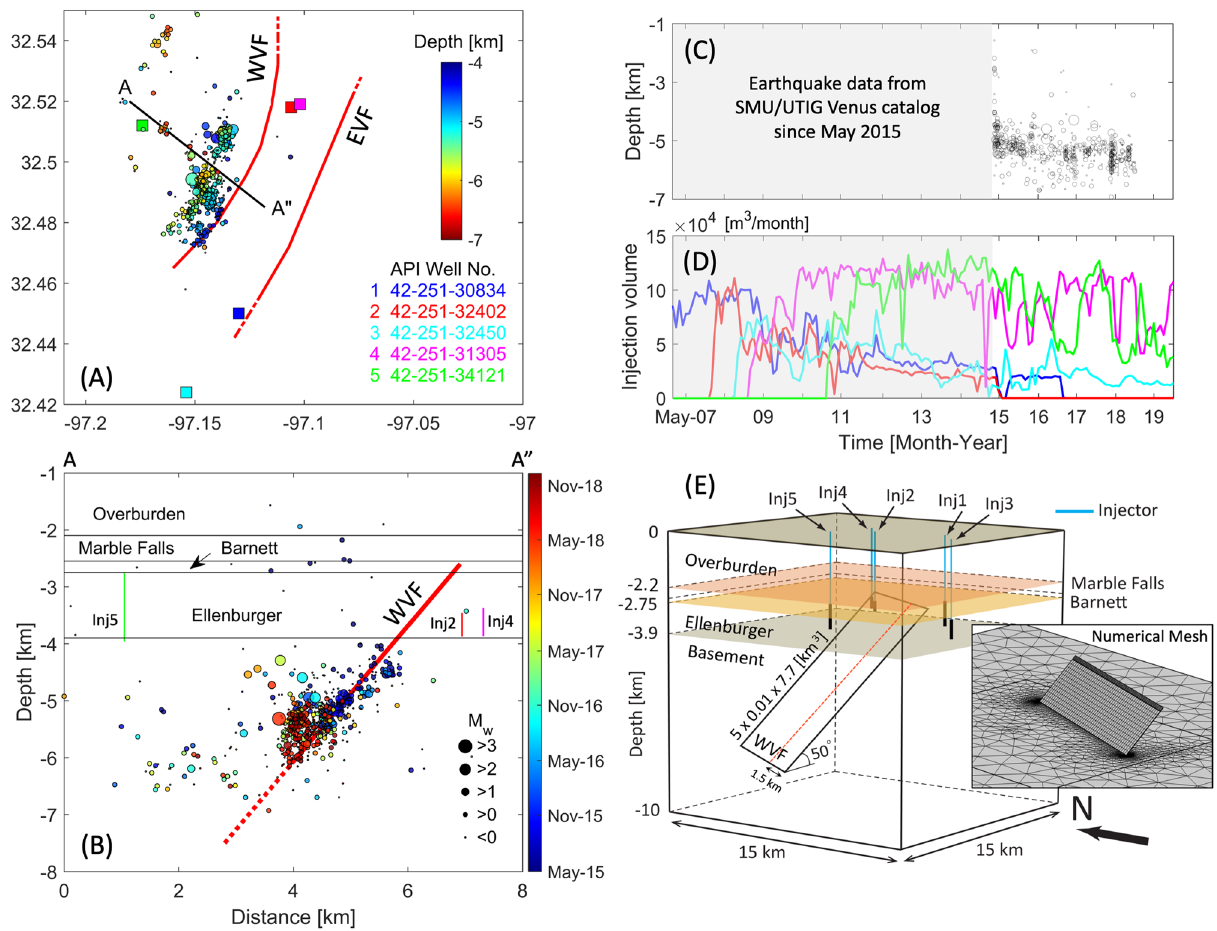
Figure 2. ( A ) Location map of earthquakes and faults near Venus, TX. Faults interpreted on the reflection data are shown at the top of the base- ment ( EVF Eastern Venus fault; WVF Western Venus fault). Five colored squares represent the SWD wells; circles are the earthquake catalog color coded by depth. ( B ) Cross-section along line A–A” with projected WVF, SWD wells and hypocentral locations (circles scaled by magnitude and colored by time). WVF extends to the basement ( 6.1 km of depth) as imaged from the seismic reflection ∼ profiles given in 29 . ( C – D ) Earthquake catalogs and injection volume through the SWD wells over time. ( E ) Schematic description of 3-D numerical domain including five layers and one fault. SWD wells are modeled as line sources. Cubic meshes are implemented for the fault to solve mechanical behaviors, whereas tetrahedral ones are for the remaining domain. Data of Coulomb stress components are obtained along the orange dash